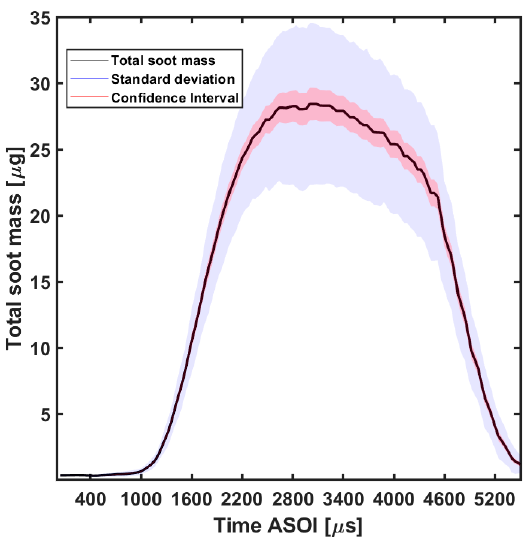
Figure 3. Total soot mass for the diesel at nominal condition.